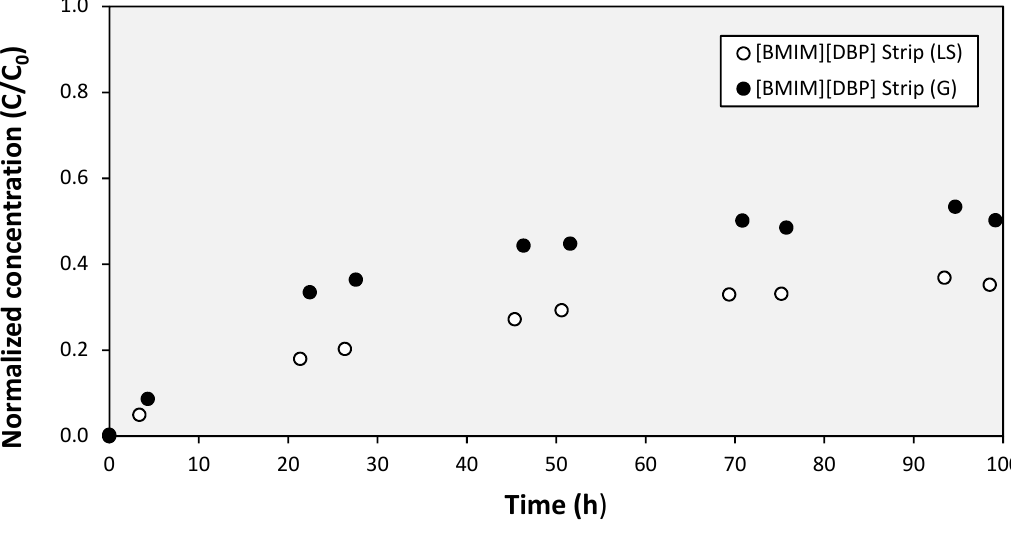
Figure 13. Evolution of the concentration of lignosulphonate (LS), glucose (G) in the stripping compartment with SILM with [BMIM][DBP] in PTFE.